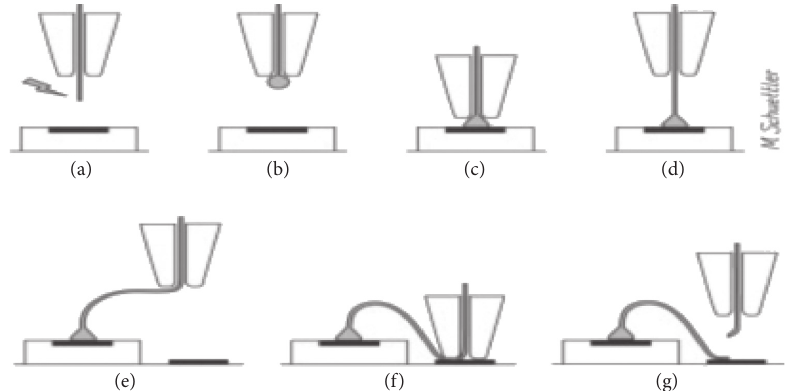
Figure 4: Process of wire bonding.